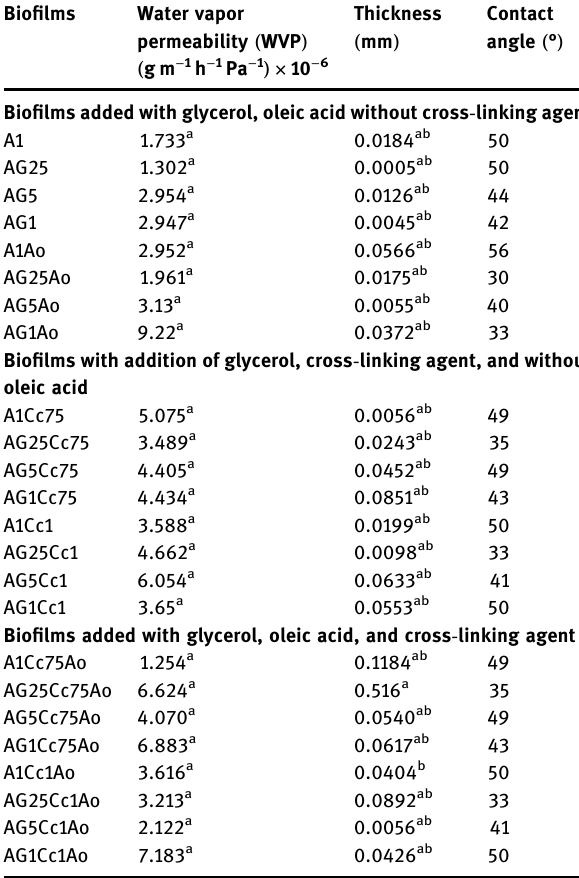
Table 5: Bio fi lms properties, water vapor permeability, thickness, and contact angle Bio fi